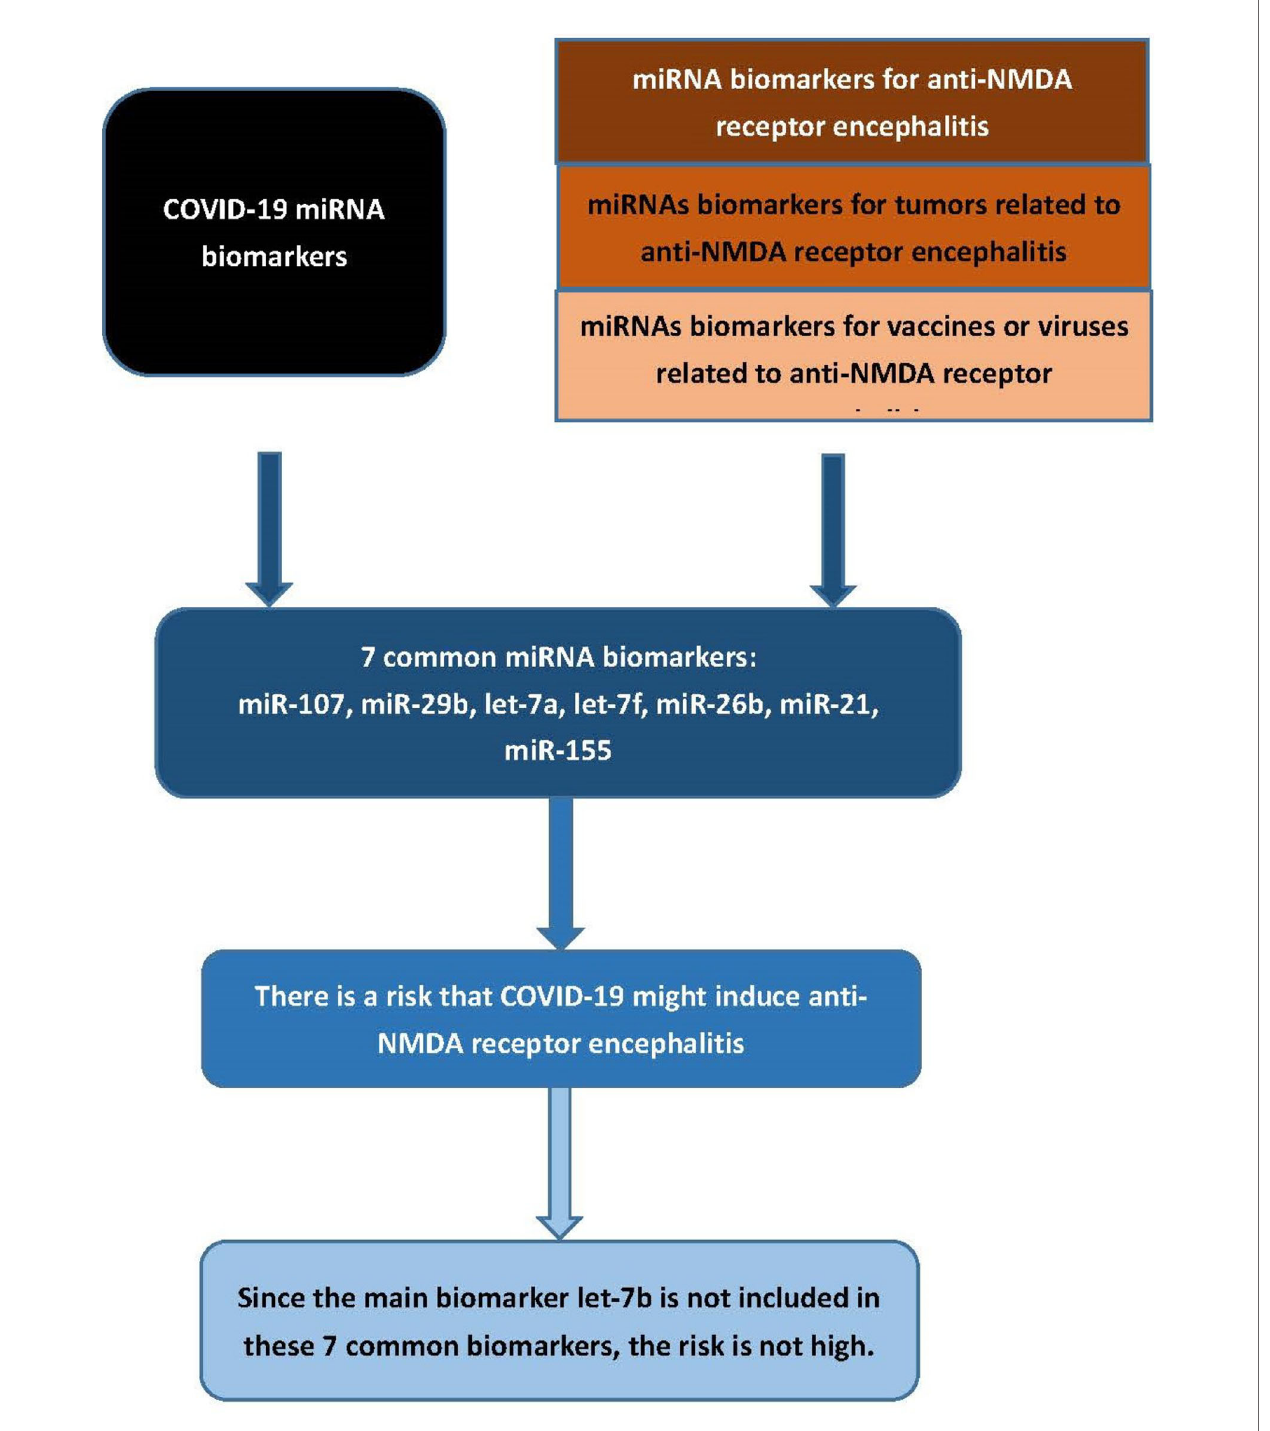
FIGURE 2 | Flowchart of the